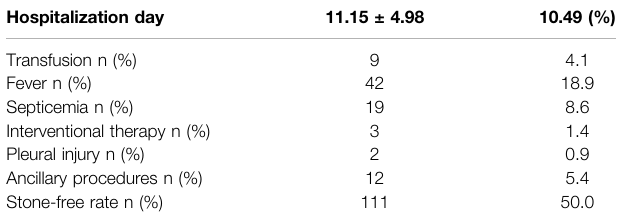
TABLE 2 | Postoperative outcome variable ( n = 222).